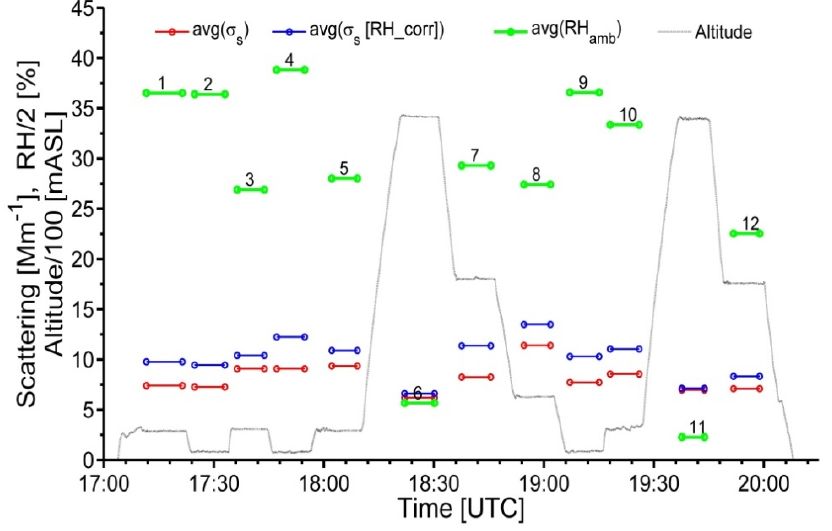
Figure 4. The same as Figure 3, except for the dry scattering measured by nephelometer (red lines) and ambient scattering obtained with measured f(RH) (blue lines) at 0.55 µm wavelength and ambient RH (green lines). FLs are labeled with numbers 1 through 12 on top of green